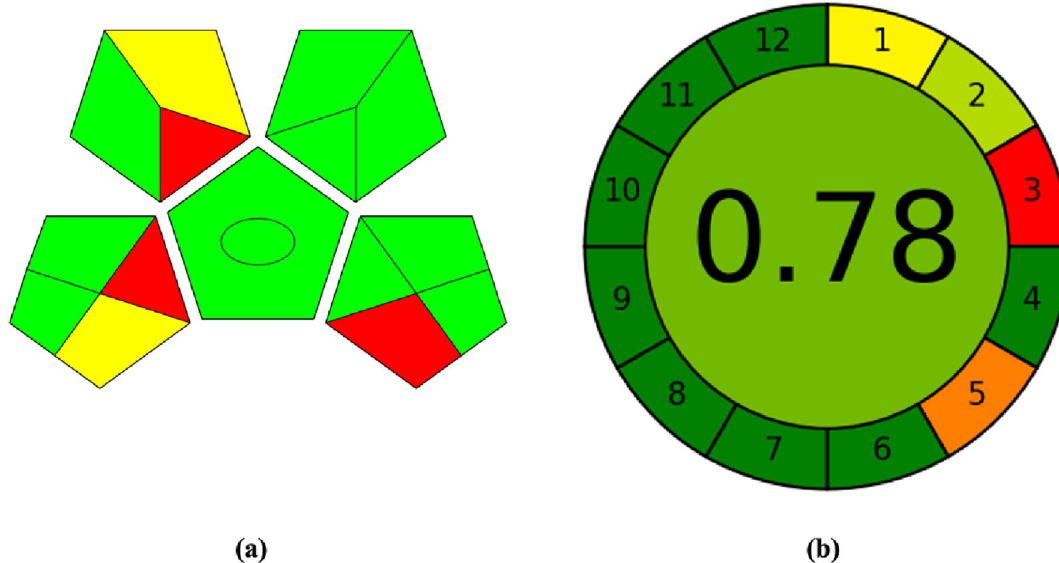
Figure 6. Assessment of the greenness profile of the proposed method by ( a ) GAPI, ( b )